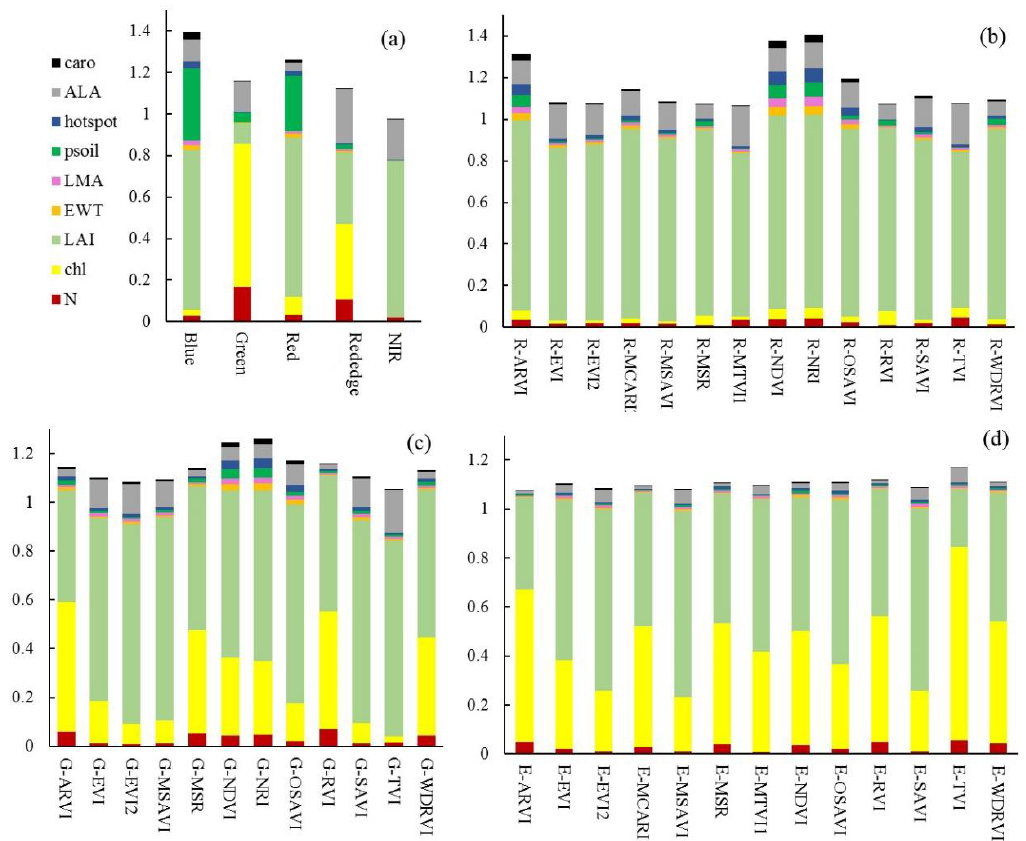
Figure 5. Results of global sensitivity analyses for the ( a ) five-band reflectance, ( b ) R-VIs, ( c ) G-VIs, and ( d ) E-VIs to PROSAIL inputs using the EFAST method.